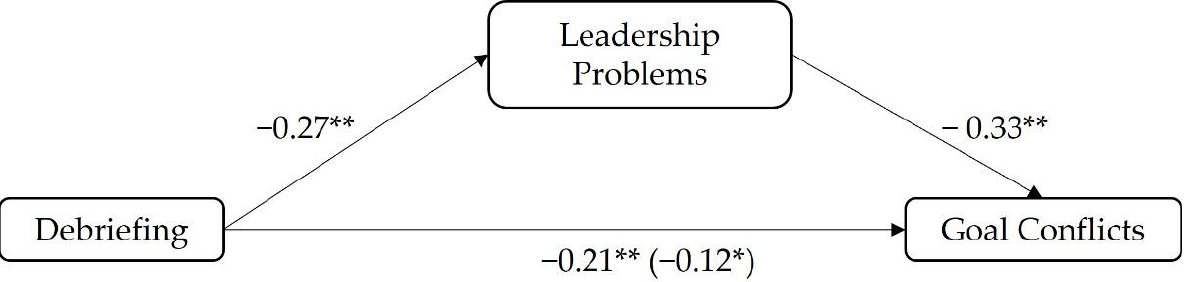
Figure 3. Results of Hypothesis 2b: * p < 0.05; * * p < 0.001.